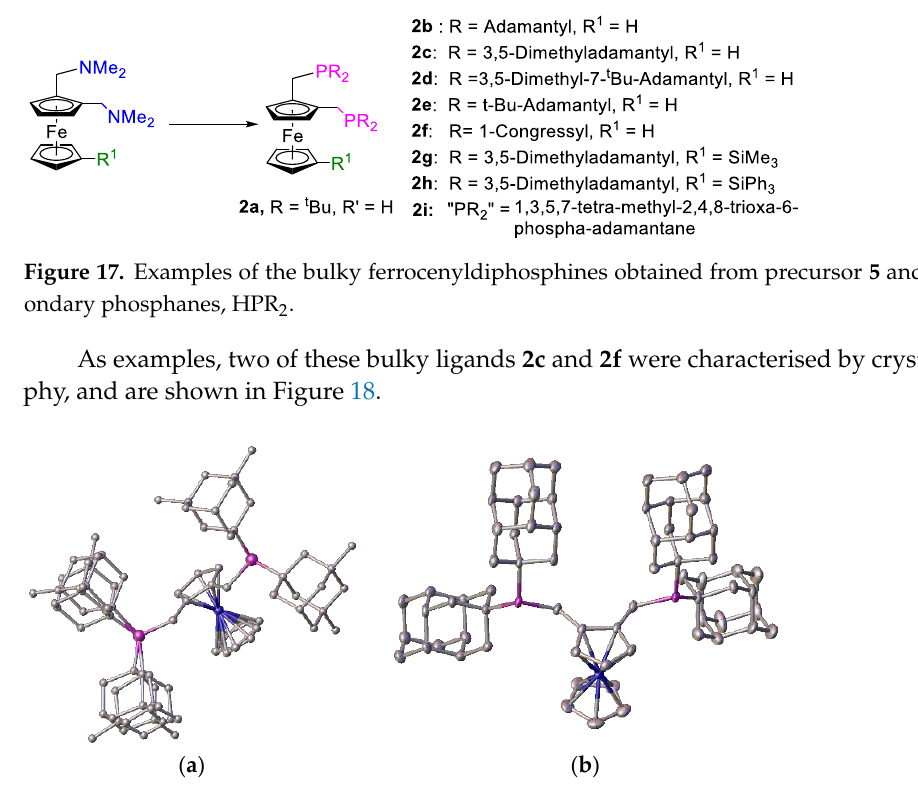
Figure 16. ( a ) Side view and ( b ) top view of palladium dichloride complex of butphos , 2a [Pd(L 2a )Cl 2 ].